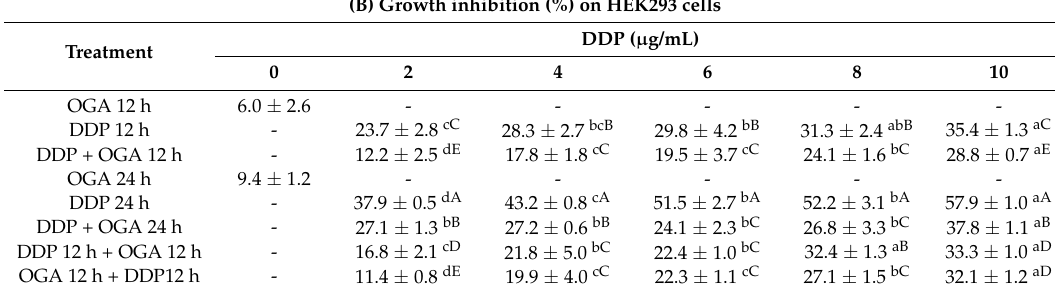
Table 1. Cont. (B) Growth inhibition (%) on HEK293